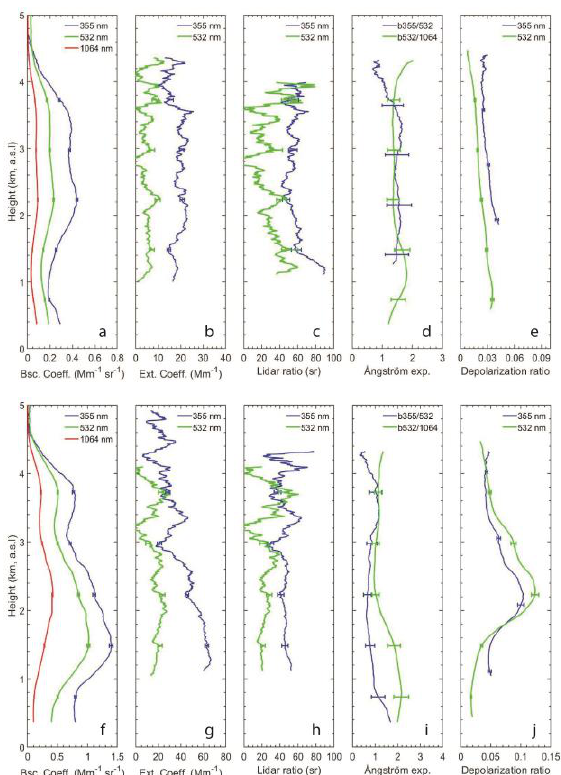
Figure 3. (a) and (f) mean particle backscatter coefficients (at three wavelengths), (b) and (g) extinction coefficients (at two wavelengths), (c) and (h) the corresponding extinction-to-backscatter ratios, (d) and (i) backscatter-related Ångström exponents, and (e) and (j) particle depolarization ratios measured at Punta Arenas (top) on 4 February 2019, 06:00-09:00 UTC and (bottom) on 5 February 2019, 08:00-09:00 UTC. Error bars (standard deviation) include systematic uncertainties and signal